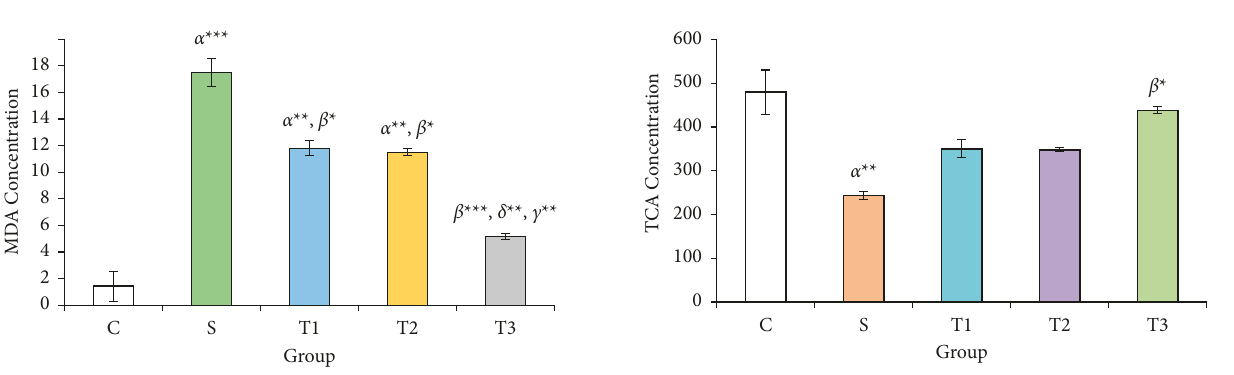
Figure 1: MDA concentration in ovarian tissue of studied animals. Figure 2: Serum TAC levels of animals in the study groups. Each